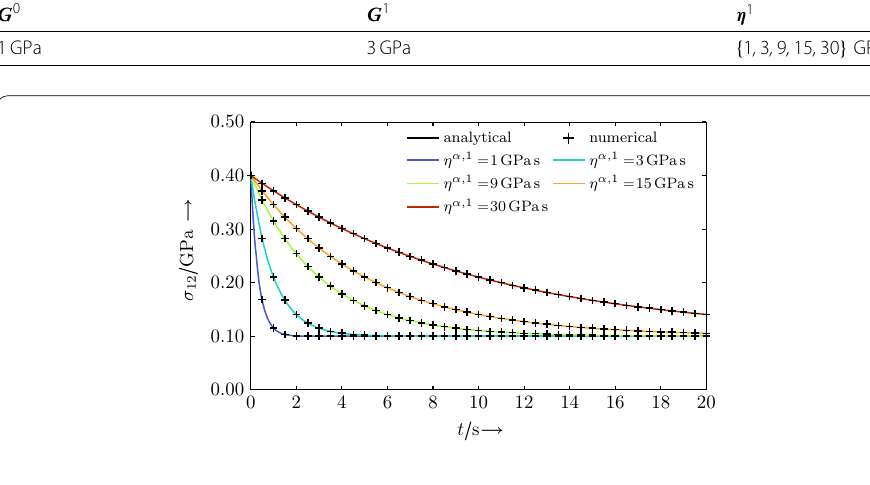
Fig. 3 Relaxation test, one phase: Comparison of numerical and analytical solution